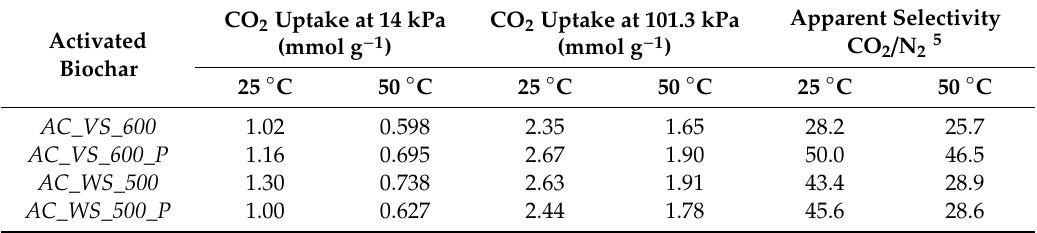
Table 4. CO 2 adsorption capacities and apparent selectivities (deduced from single-component adsorption isotherms) for the activated biochars at 25 and 50 ◦